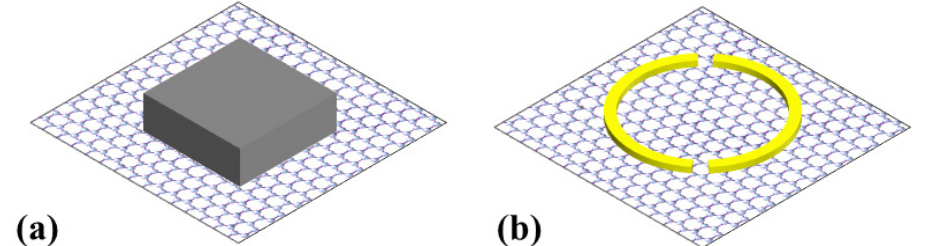
Figure 5. Graphene-based multi-band terahertz metamaterial absorbers using nonstructured graphene film. ( a ) dielectric-graphene-based structure; ( b ) Hybrid metal-graphene-based structure.